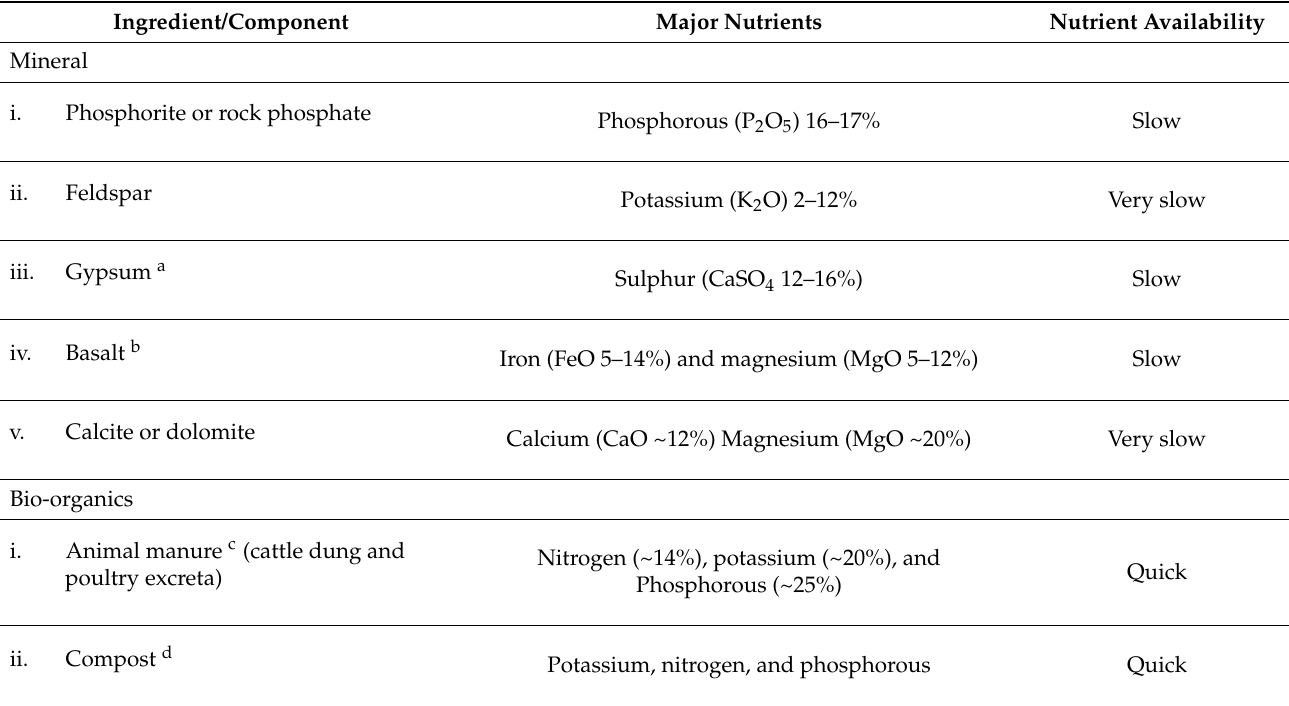
Table 2. Basic compositional make-up of different components employed in the production of BOMFs. Ingredient/Component Major